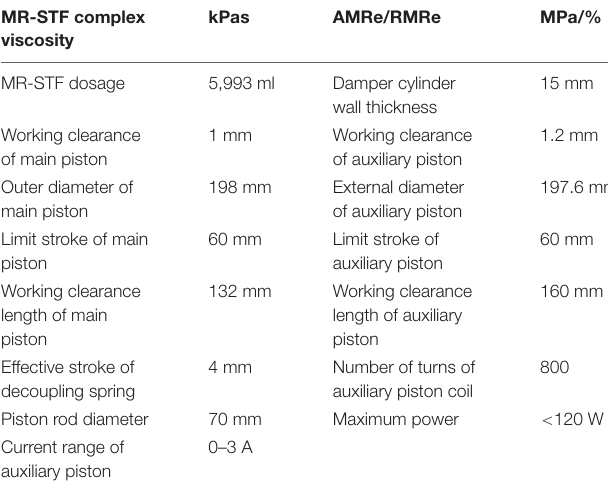
TABLE 2 | Basic structural parameters of the